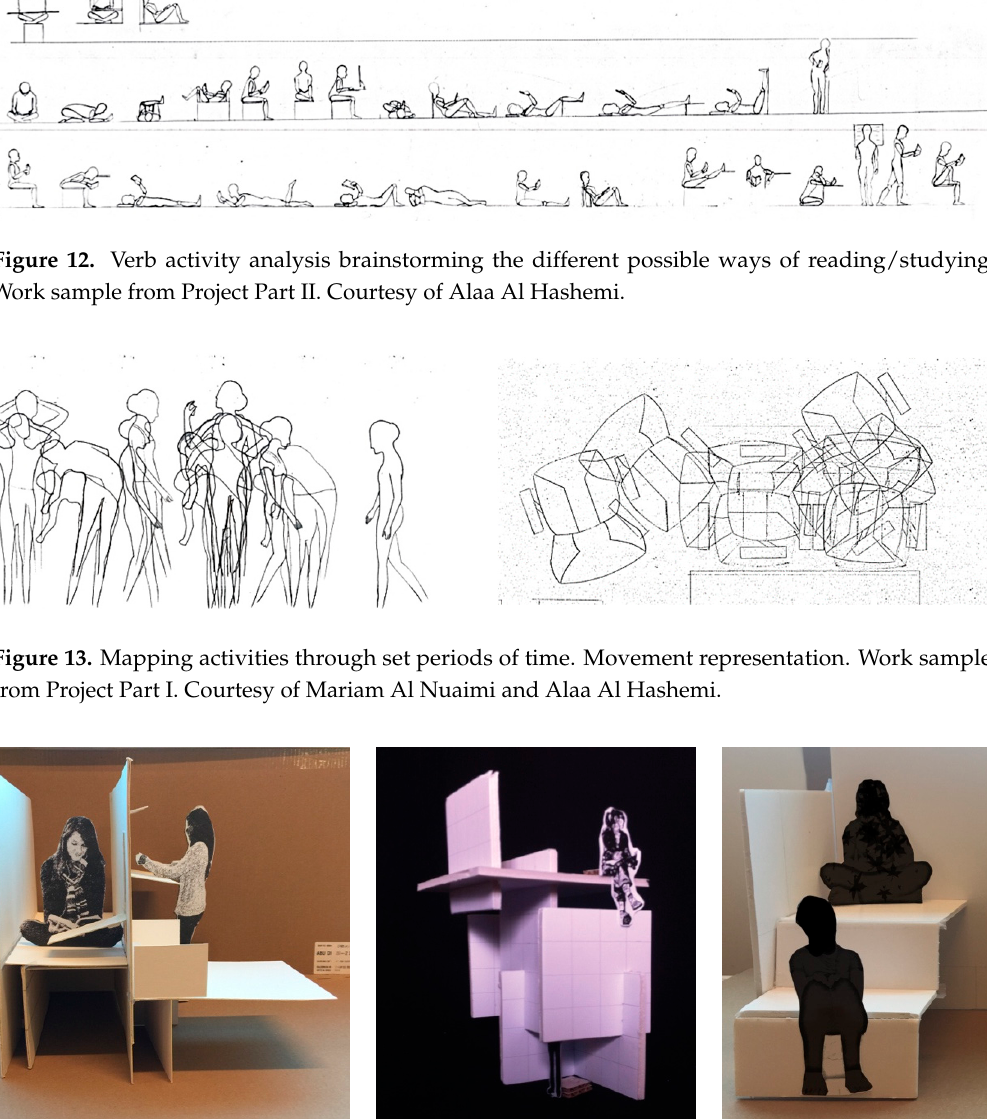
Figure 14. Spatial exploring and scale relativity to human figures. Curated space occupation. Work sample from project Part II and Part III. Courtesy of Alaa Al Hashemi, Shaikha Al Mulla and Fatima Al Wheibi.